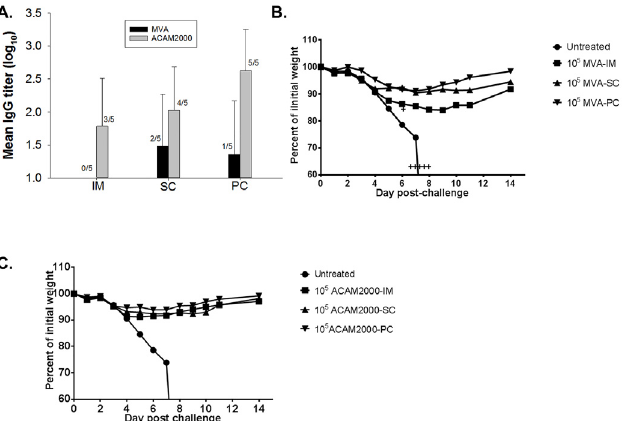
Fig 1. Immunogenicity and protection conferred by MVA and ACAM2000. Groups of mice were vaccinated with 10 5 pfu of MVA or ACAM2000. Each virus was administered at the indicated dose via the intramuscular (IM), subcutaneous (SC), or percutaneous (PC) routes. Antisera were obtained from mice after three weeks and tested for vaccinia-specific IgG by ELISA. The mean IgG titers are presented ( A ). For computational purposes, a mouse with below detection level of IgG was assigned a titer of 1.0 (log 10 ). Fractions indicate the number of seropositive animals in each group, with error bars representing standard deviation. Mice were challenged intranasally with 10 LD 50 (1.5 x 10 5 pfu) of vaccinia virus (strain Western Reserve). Morbidity, as measured by mean weight changes post-challenge, is shown for the MVA treatment groups ( B ), and for the ACAM2000 treatment groups ( C ). The “ Untreated ” control group was the same for both the MVA and ACAM2000 groups. A “ + ” sign represents a mouse that succumbed to infection.